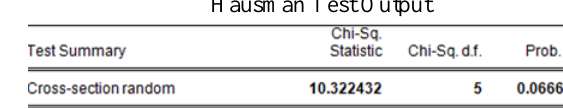
Hausman Test Output